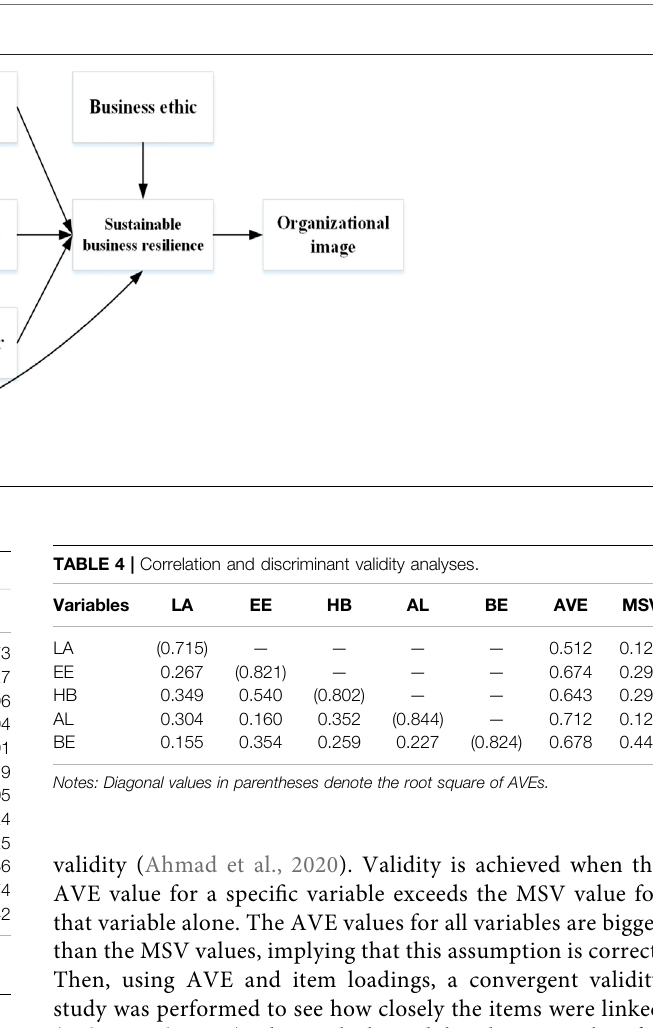
TABLE 3 | Descriptive statistics of the data. Variables